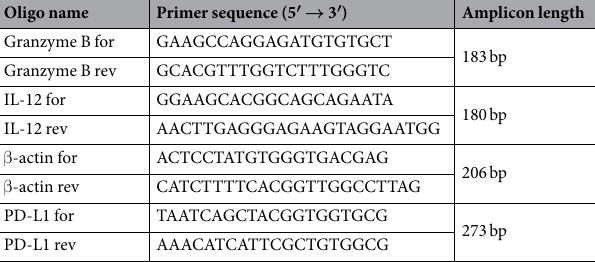
Table 1. List of primers used for qPCR